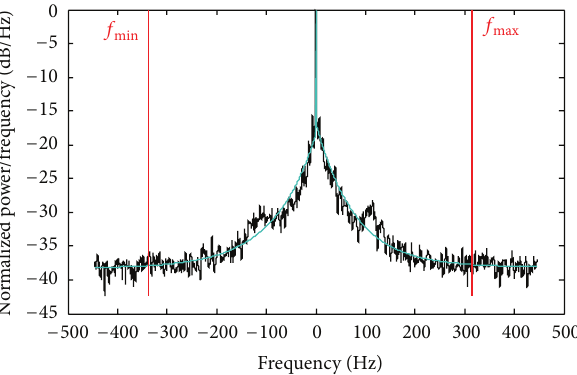
Figure 4: Frequency limits for Example 1.